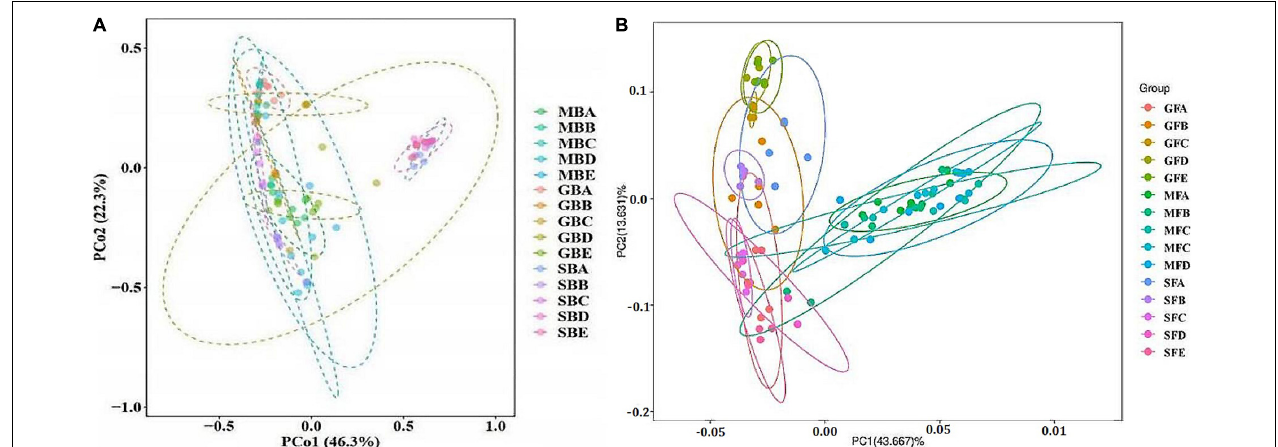
FIGURE 5 | Principal coordinate analysis (PCoA) of rice phyllosphere bacteria (A) and fungi (B) among different elevational sites and growth stages. (A) PCoA of rice phyllosphere bacteria. (B) PCoA of rice phyllosphere fungi. B, bacteria; F, fungi. M, seedling stage; G, heading stage; S, mature stage. (A) 580 m asl; (B) 680 m asl; (C) 780 m asl; (D) 880 m asl; (E) 980 m asl.